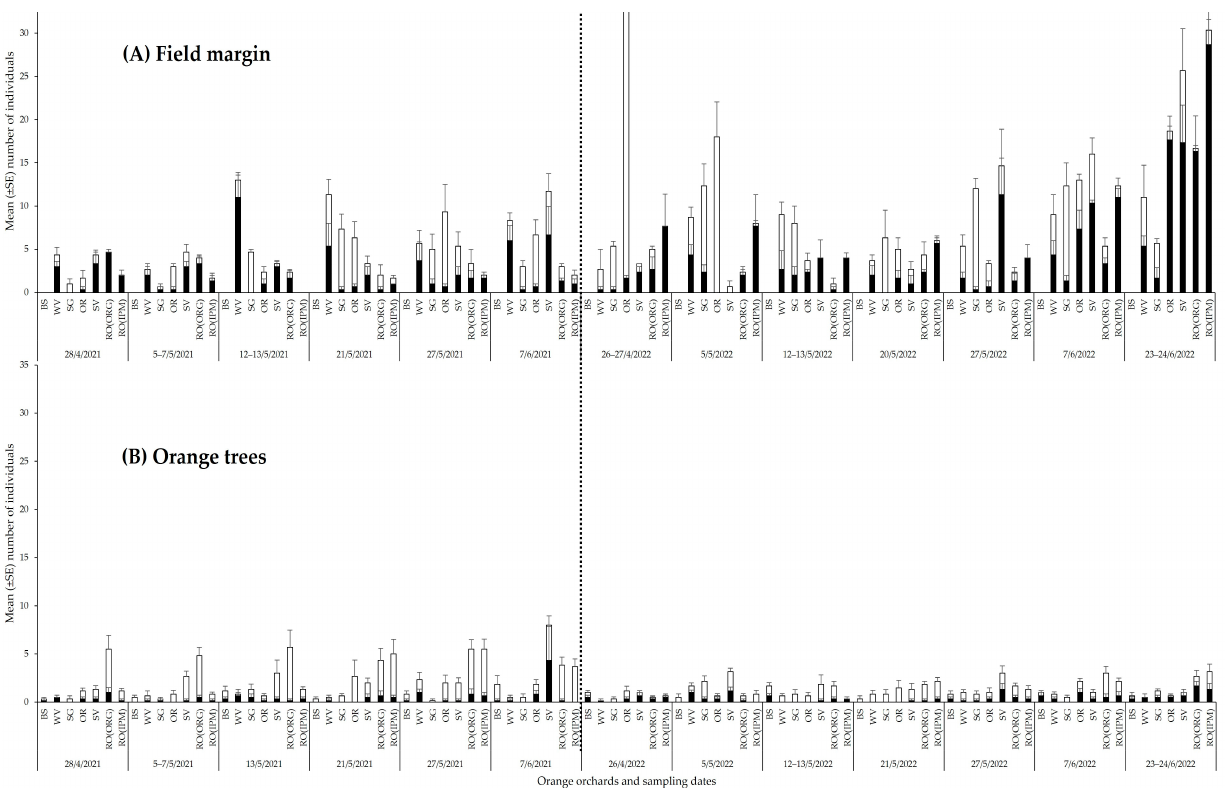
Figure 7. Total abundance (mean ± SE) of arachnid and insect predators ( A ) in fi eld margins, ( B ) on orange trees in orchards with di ff erent fi eld margin management: BS—bare soil; WV—weed vege- tation; RO(ORG)—rosemary hedgerow (organic orchard); RO(IPM)—rosemary hedgerow (IPM or- chard); OR—oregano hedgerow; SG—sage hedgerow; SV—savory hedgerow. Identical le tt ers above the error bar indicate no statistically signi fi cant di ff erences among orchards.